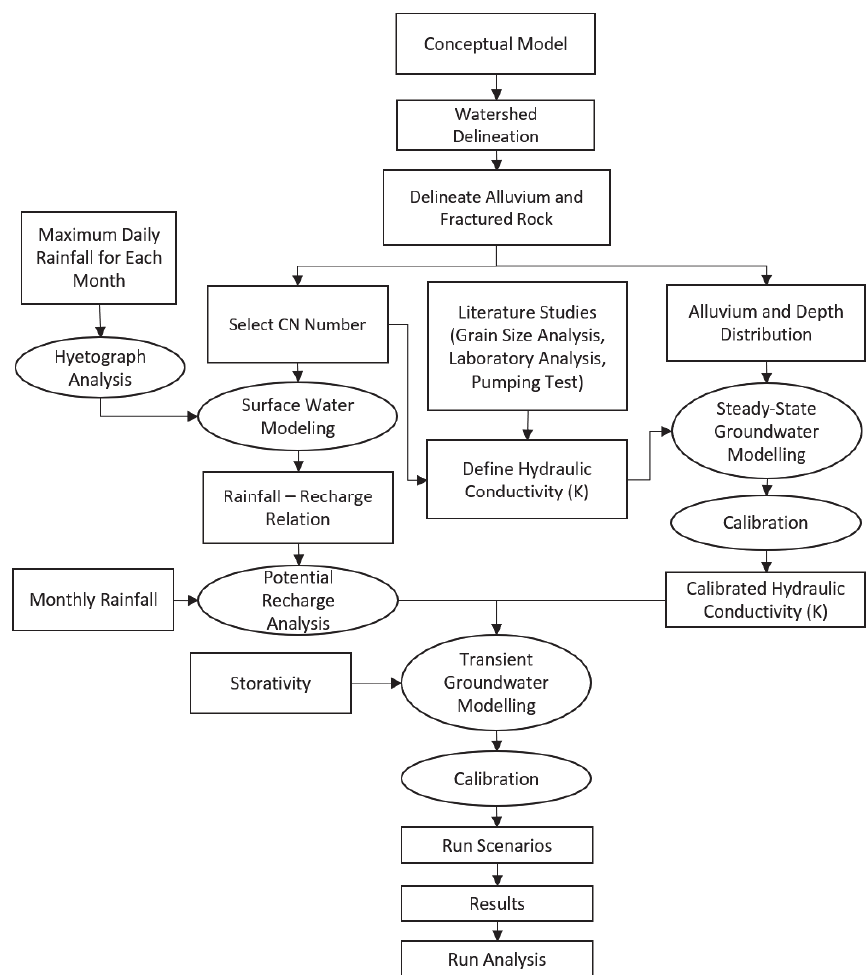
Figure 9. The methodology flow chart in this study.